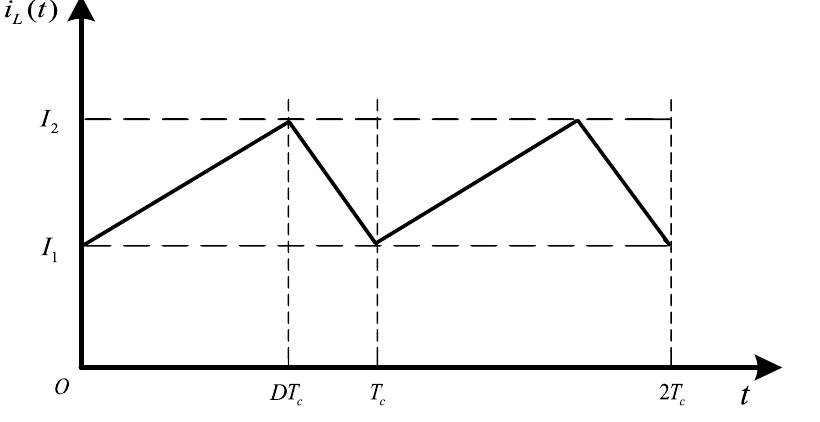
Figure 2. Inductor current waveform in a